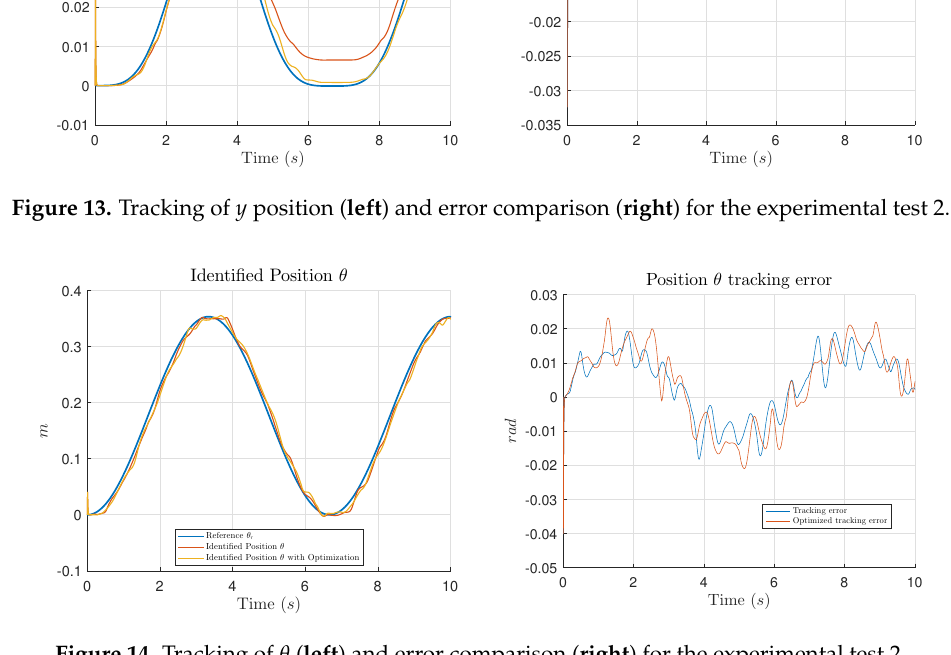
Figure 14. Tracking of θ ( left ) and error comparison ( right ) for the experimental test